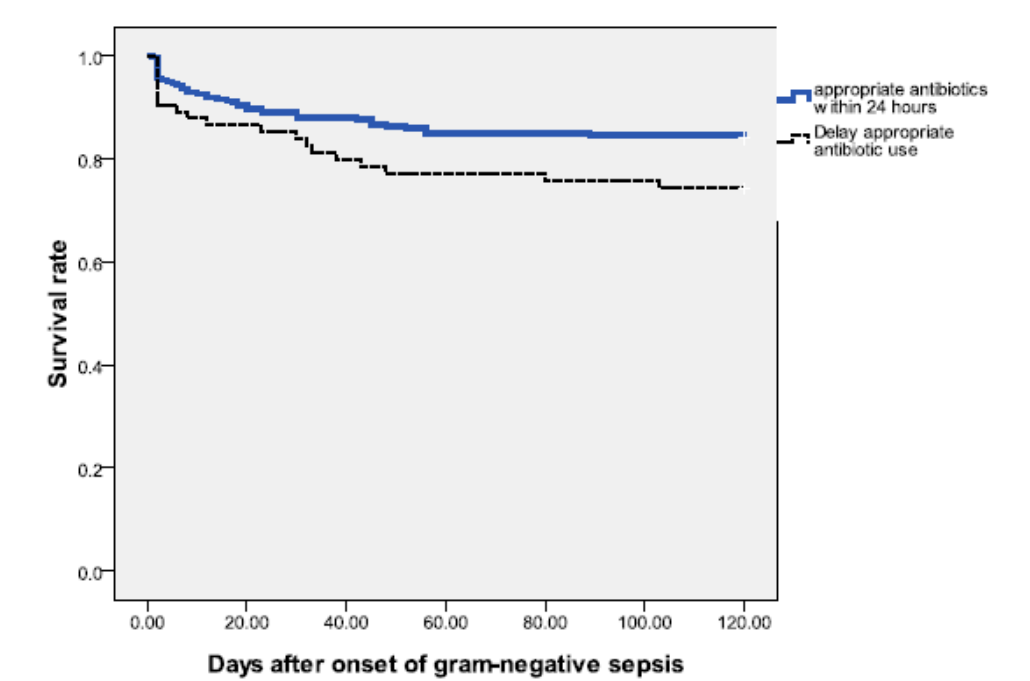
Figure 1. Survival following onset of gram-negative sepsis from neonates in the neonatal intensive care unit (NICU). The Kaplan–Meier graph is stratified by the episodes treated with appropriate antibiotics within 24 h and those with delayed initial appropriate antibiotic treatment; [log rank test = 0.051]. Table 3. Outcome comparisons of Gram-negative bacteremia treated with inadequate antibiotics versus adequate antibiotics.